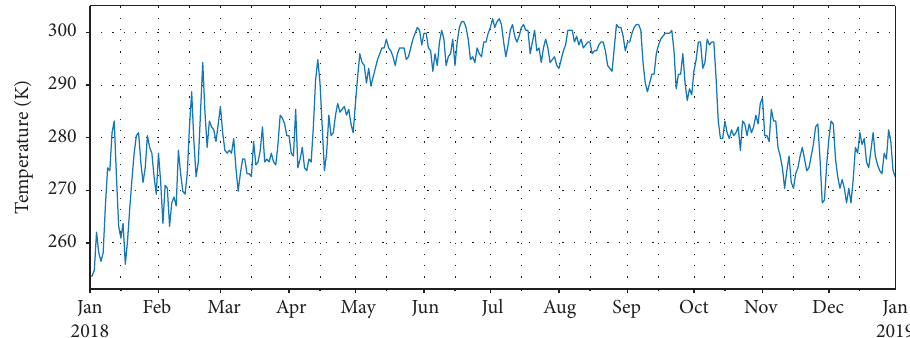
Figure 4: Daily average temperature values for Indianapolis, U.S., in 2018.